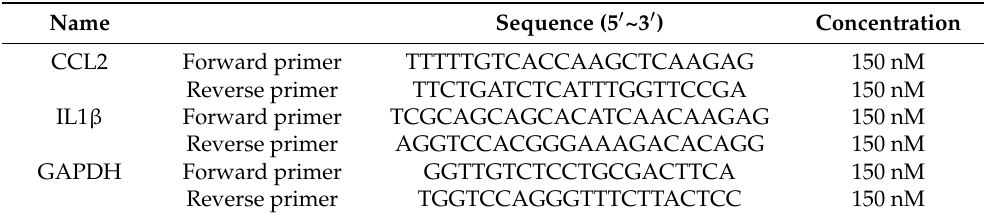
Table 5. Mouse primers for quantitative real-time PCR